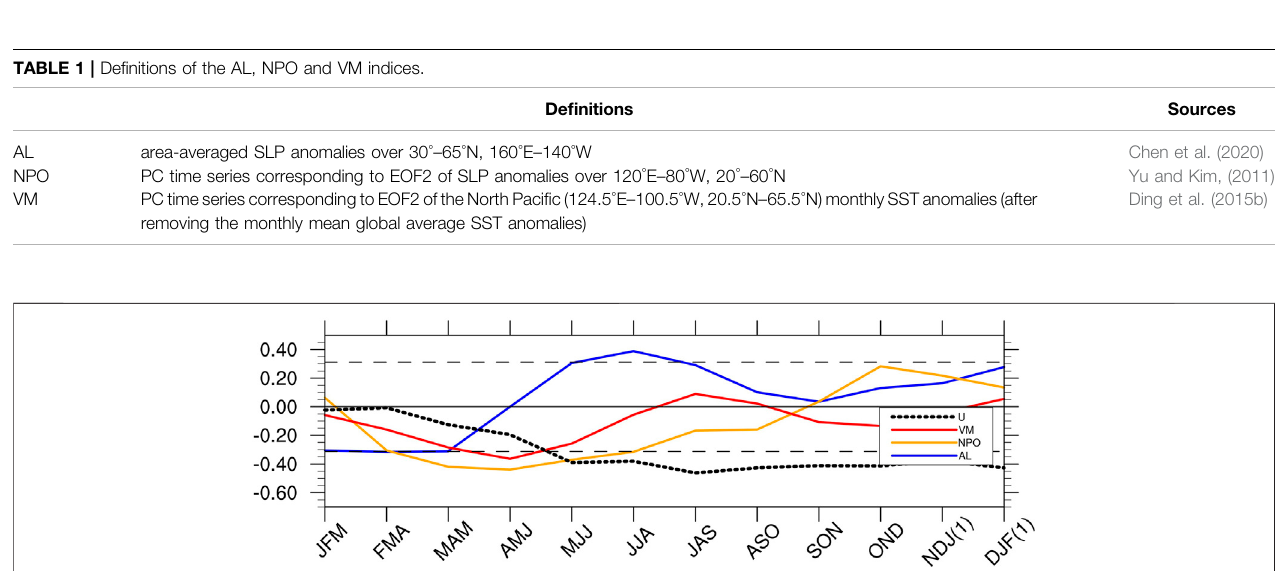
FIGURE6| Lagcorrelationcoef fi cientsbetweentheJFMSHI andtheAL(blue),NPO(yellow),VM(red),U(black)indicesduring1979 – 2020.TheUindexisde fi ned as the regional mean 10-m zonal wind anomaly in the equatorial eastern-central Paci fi c (10 ° S – 10 ° N, 180 ° E – 120 ° W). The horizontal axis represents the target month of used AL,NPO,VM,andUindices.Thedashedlinesindicatethecorrelationcoef fi cientsigni fi cantatthe95%con fi dencelevel.Timenotationsindicatetheyearalongside and (1) indicate time comes to the next year.